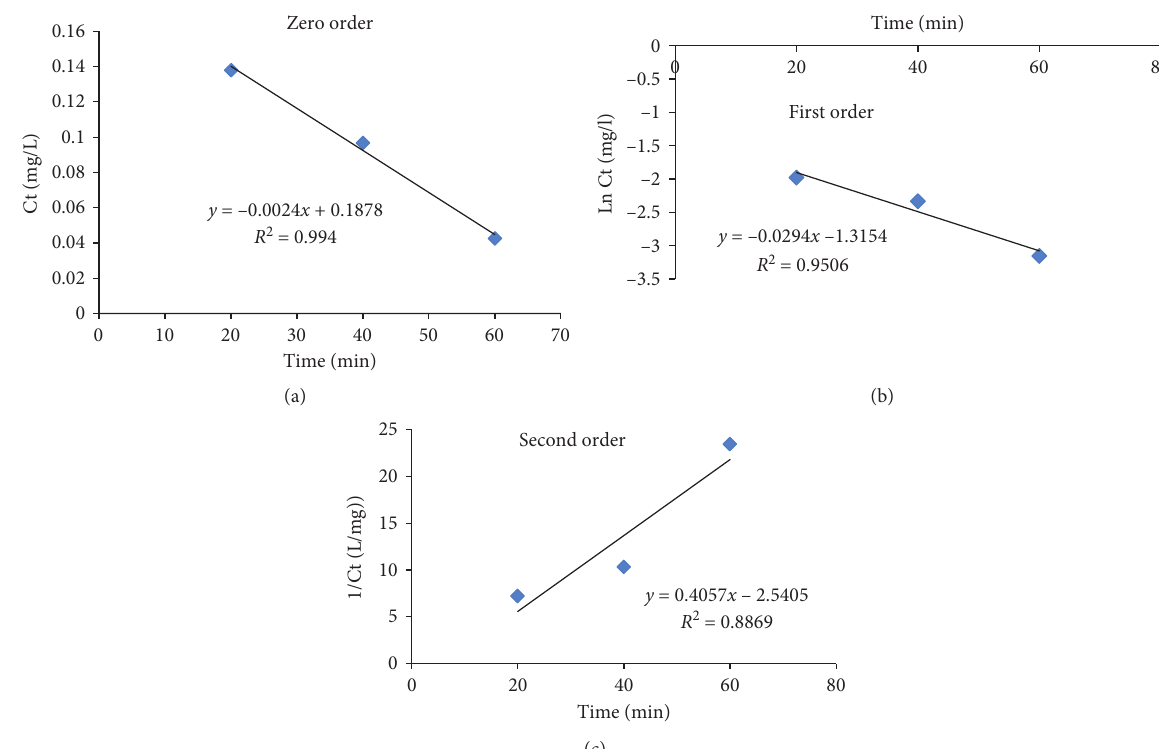
Figure 8: The rate of trifluralin removal reaction in the UV/ZnO process within optimal condition (the initial concentration of tri- fluralinand ZnO is 0.6mg/L and 100mg/L, respectively, pH � 9, UV �